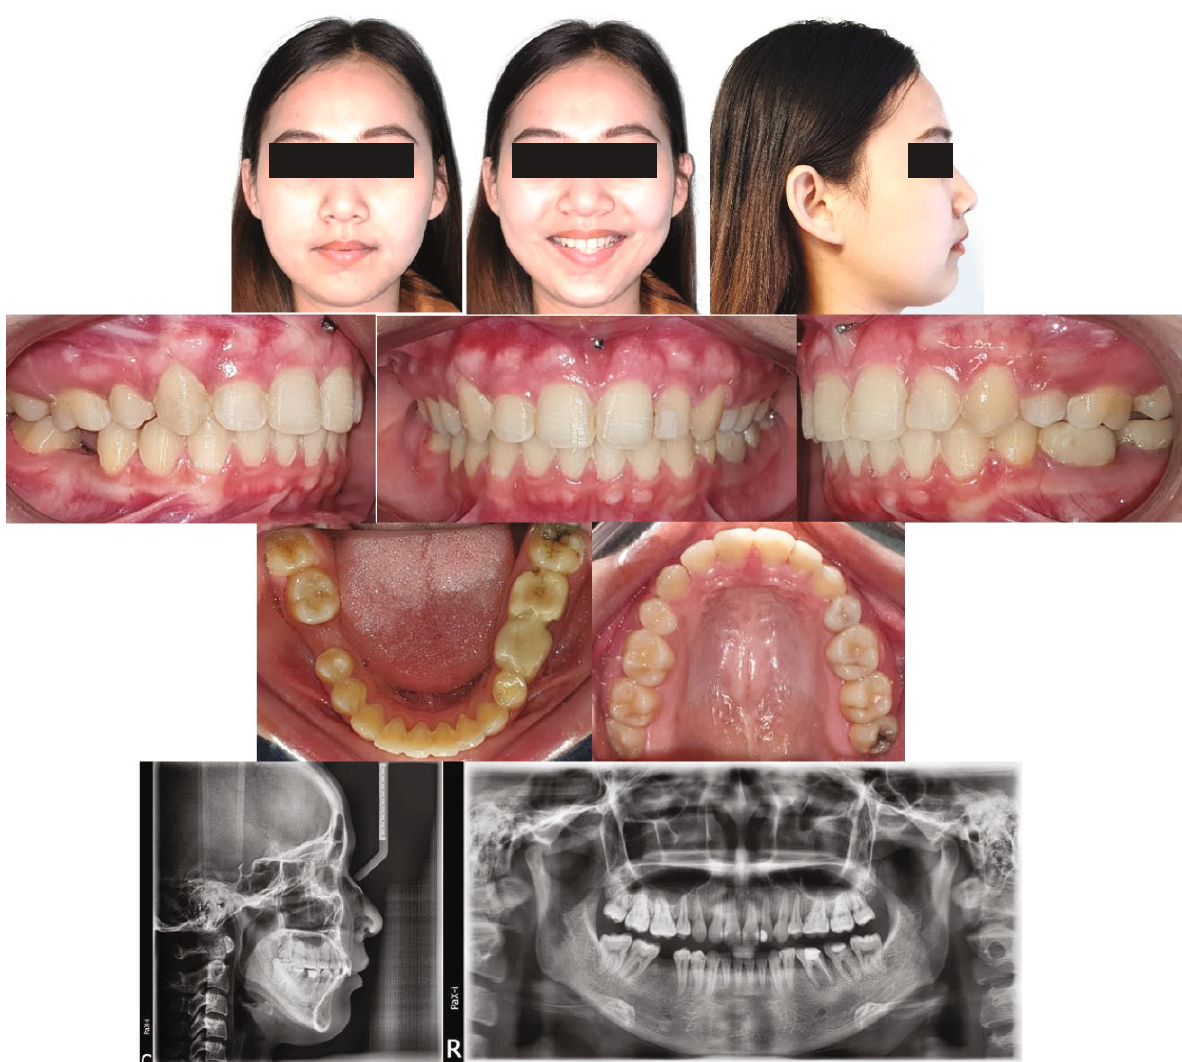
Figure 6: Posttreatment